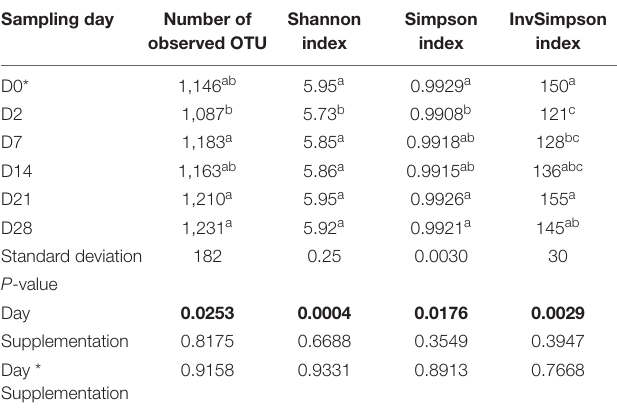
*D0: Basal value before the first TMS administration. For each column, means with different superscripts differ at P < 0.05. Significant P-values are in